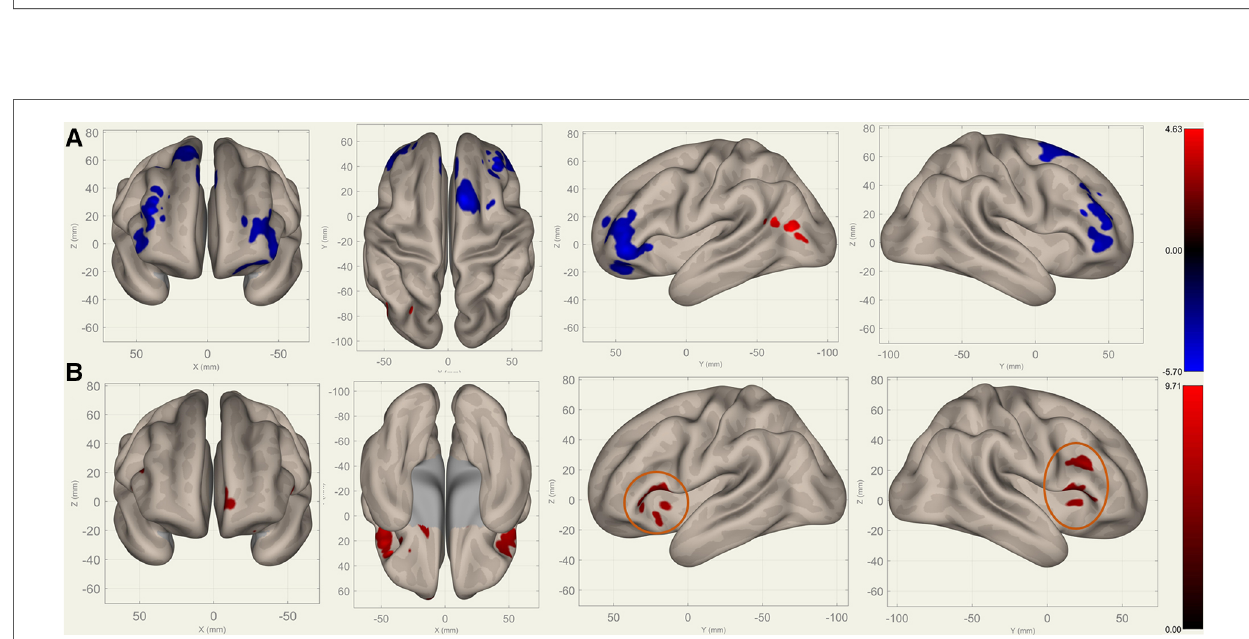
FIGURE 3 Perioperative seed-based connectivity changes in the bilateral caudates (seed points) ( T . 4 : 78, voxel threshold p (cid:1) unc , 0 : 001, cluster threshold p (cid:1) FDR , 0 : 05). ( A ) S1>S0: The decreases were most prominent in the left frontal pole (MNI [ (cid:1) 38 þ 42 (cid:1) 10], cluster size: 605 voxels, peak p (cid:1) unc , 0 : 001, size p (cid:1) FDR , 0 : 001), right frontal pole (MNI [ þ 38 þ 36 þ 28], cluster size: 441 voxels, peak p (cid:1) unc , 0 : 001, size p (cid:1) FDR ¼ 0 : 001), right superior frontal gyrus (MNI [ þ 10 þ 14 þ 62], cluster size: 338 voxels; peak p (cid:1) unc , 0 : 001, size p (cid:1) FDR ¼ 0 : 002), and left superior frontal gyrus (MNI [ (cid:1) 14 þ 30 þ 36], cluster size: 36 voxels, peak p (cid:1) unc , 0 : 001, size p (cid:1) FDR ¼ 0 : 002). ( B ) S2>S1: The increases were most prominent in the left frontal orbital cortex (MNI [ (cid:1) 20 þ 12 (cid:1) 12], cluster size: 260 voxels, peak p (cid:1) unc , 0 : 001, size p (cid:1) FDR , 0 : 001), right inferior frontal gyrus (MNI [ þ 38 þ 22 þ 20], cluster size: 227 voxels, peak p (cid:1) unc , 0 : 001, size p (cid:1) FDR ¼ 0 : 001), and left frontal operculum cortex (MNI [ (cid:1) 44 þ 22 þ 12], cluster size: 182 voxels; peak p (cid:1) unc , 0 : 001, size p (cid:1) FDR ¼ 0 : 002). The orange circles indicate “ map expansion ” neuroplasticity after the